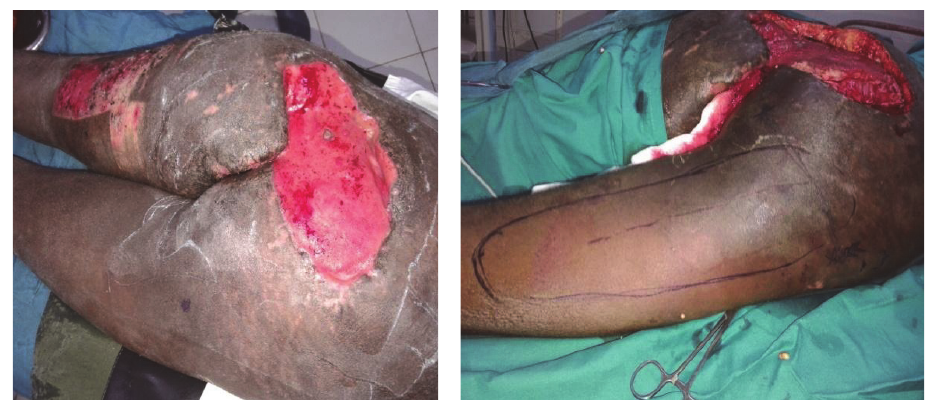
Figure 1: First patients with extensive sacral wounds and markings for the flap.